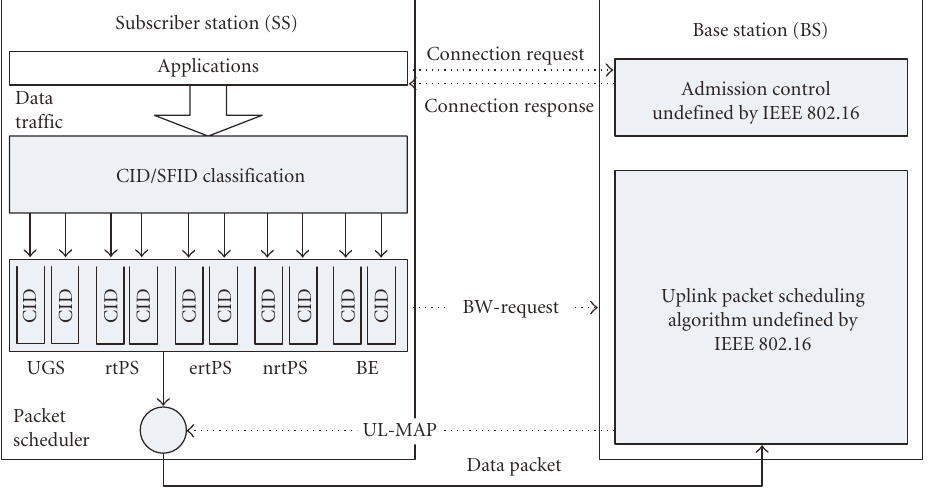
Figure 3: IEEE 802.16 QoS architecture.